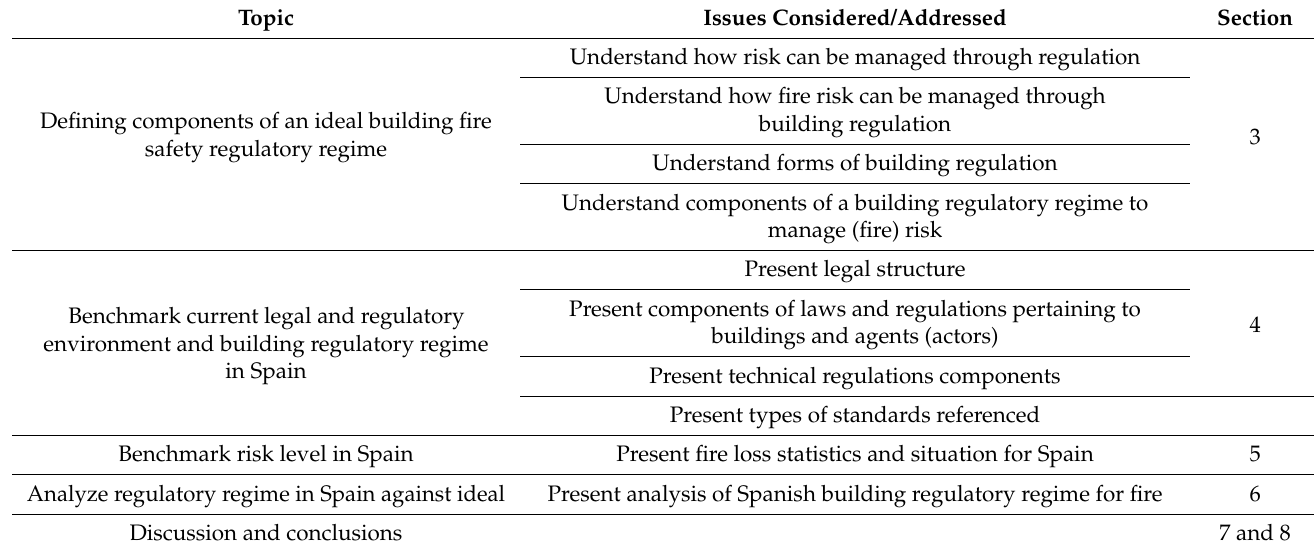
Table 1. Assessment of fire risk management in Spanish building regulatory system.